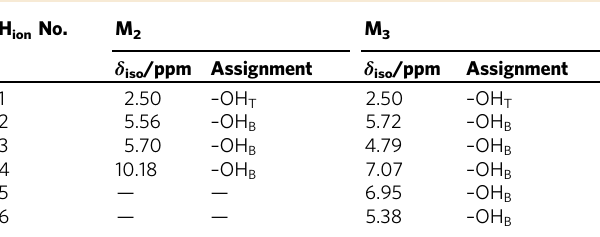
Table 1 Calculated 1 H NMR chemical shifts a for M 2 and M 3 . The corresponding structures are presented in Fig. 6.